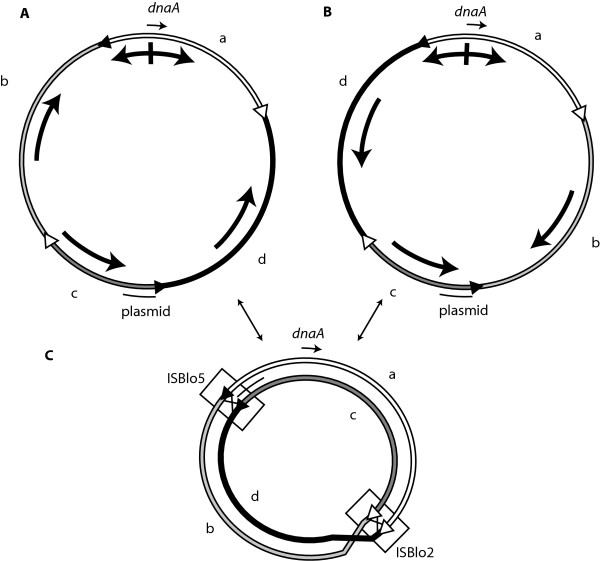
Chromosome rearrangements generating the transition between the two Bifidobacterium longum configurations. Maps of B. longum NCC2705 in configurations I (A), II (B) and the proposed mechanism mediating the transition between the two configurations (C). Segments a, b, c and d are indicated. Gene dnaA and the integrated plasmid are represented by an arrow and a thin black line, respectively. ISBlo2a and b are indicated by open triangles, ISBLo5c and d by solid ones. For each segment, thick black arrows indicate the orientation of transcription of the majority of the genes.